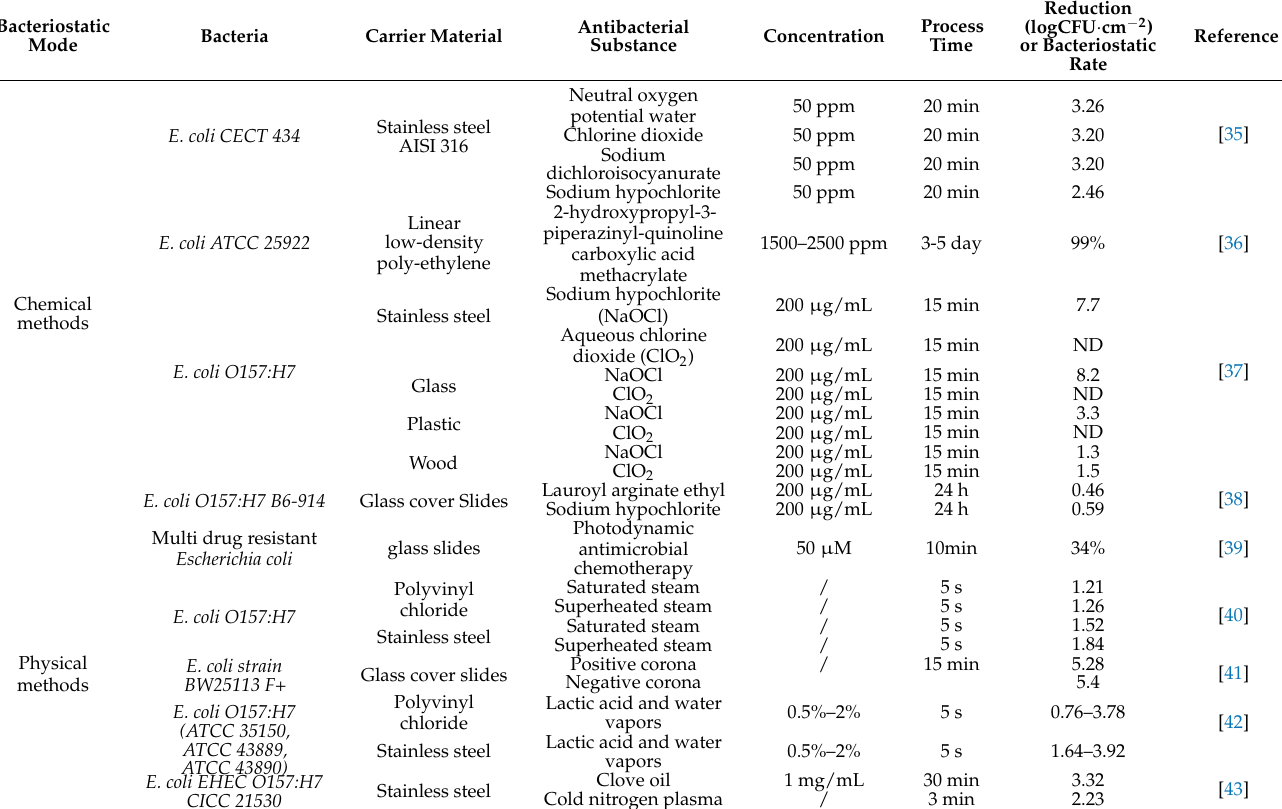
Table 1. Inhibition effect of different sterilization methods on E. coli